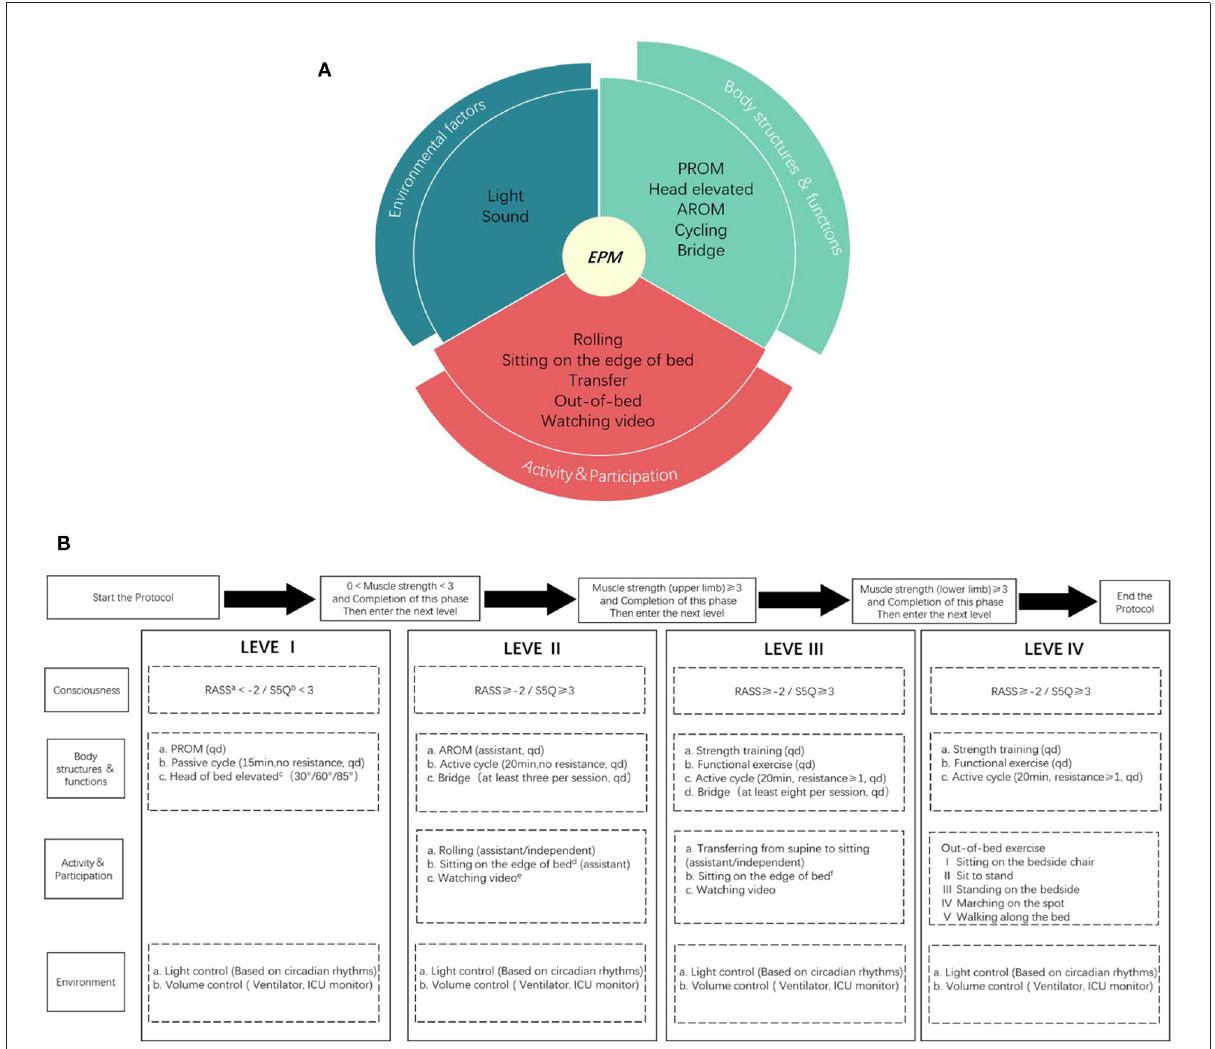
FIGURE1 ICF based progressive mobilization interventions (A) and the protocol (B) . EPM means early progressive mobilization; AROM means active range of motion; PROM means passive range of motion; Muscle strength is allowed on either limb, without requiring both limbs; The